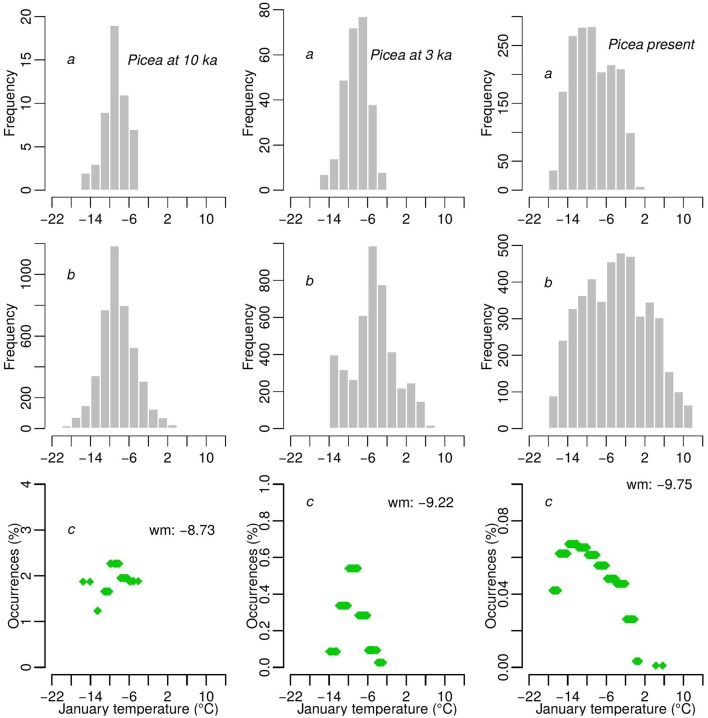
Picea as an example of how the reconstructed Tjan values for three time slices (10 ka, 3 ka, and today) were normalized. The example shows frequency histograms of sites where reconstructed Tjan is obtained (A) and the frequency of Tjan gridded values (see Figure 3) over Europe (B) within each 2°C bin. The ratios of the two frequencies (C) are used to weight Tjan values for each time slice and each species.